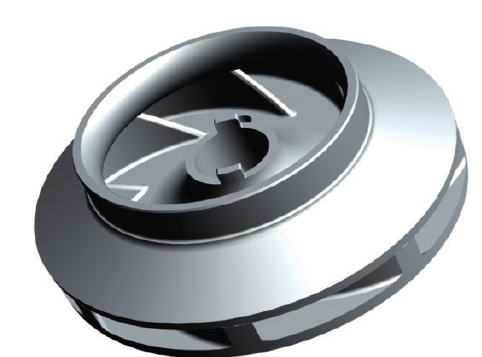
Figure 2. High speed impeller for the LOx pump of the L75 rocket